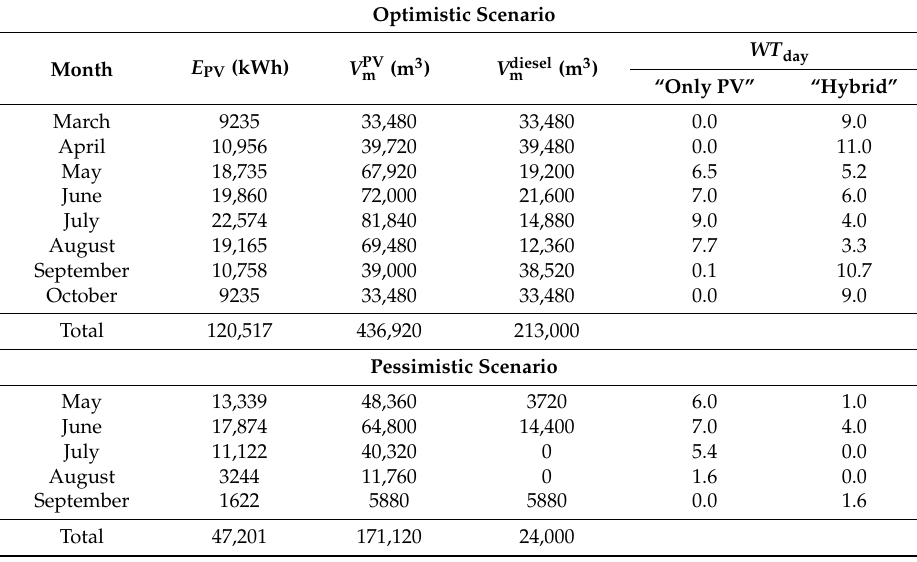
Table 2. PV energy and volume of water pumped (from PV and from diesel) in the optimistic and pessimist scenarios for “Only PV” and “Hybrid” modes. Diurnal working hours are also given for “Only PV” and “Hybrid” modes with the threshold of 95 kW to transit between these two modes.